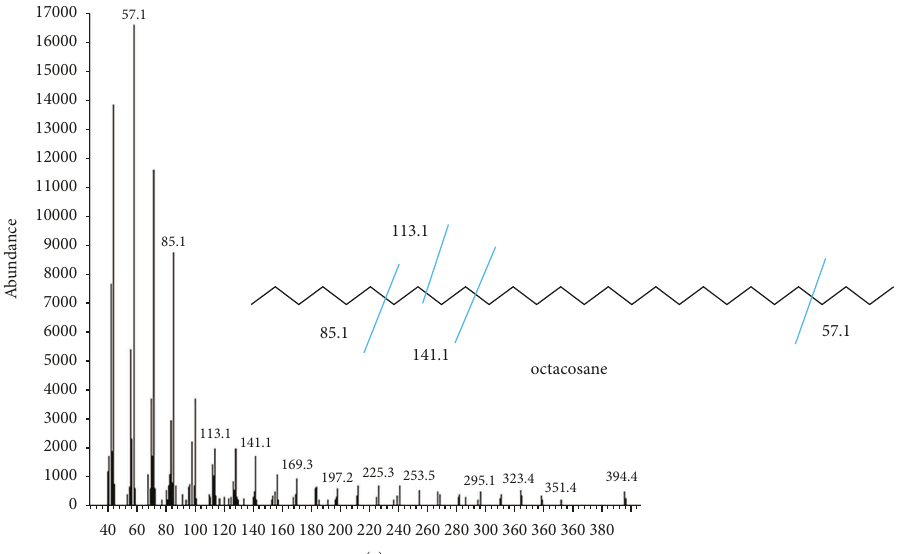
Figure 10: MS spectrum and the fragmentation pattern of